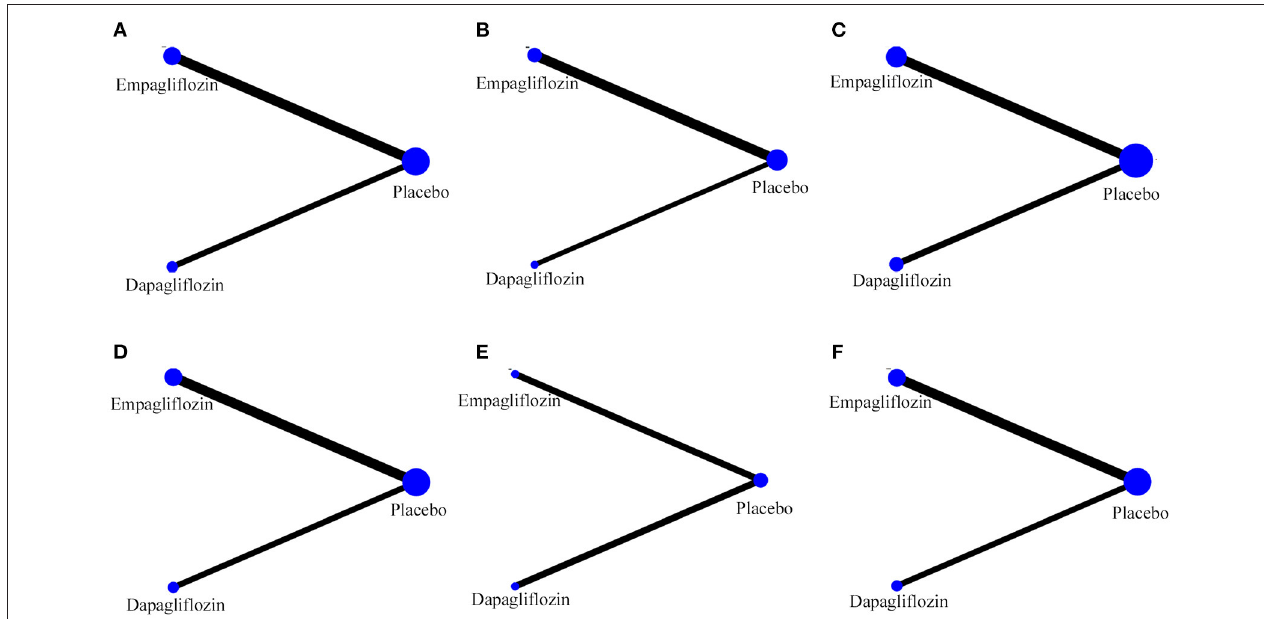
FIGURE 2 | Evidence of network. (A) Hospitalization for HF; (B) exacerbation of HF; (C) all-cause death; (D) CV death; (E) CV death or hospitalization for HF; (F) hypoglycemia.